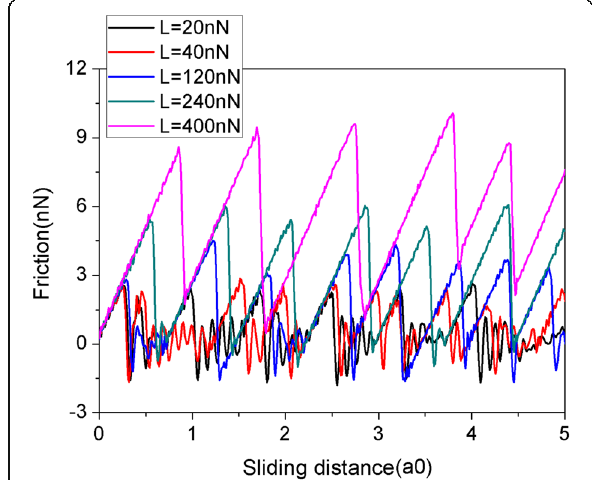
Fig. 10 Friction force as a function of sliding distance at various normal loads ( L ) for the friction process without the movement constraint of graphene in the y direction. The flake has a square shape with a size of 5.8 nm. Here, a0 (= 9.99 Å) is the lattice spacing of Au(111) along the sliding